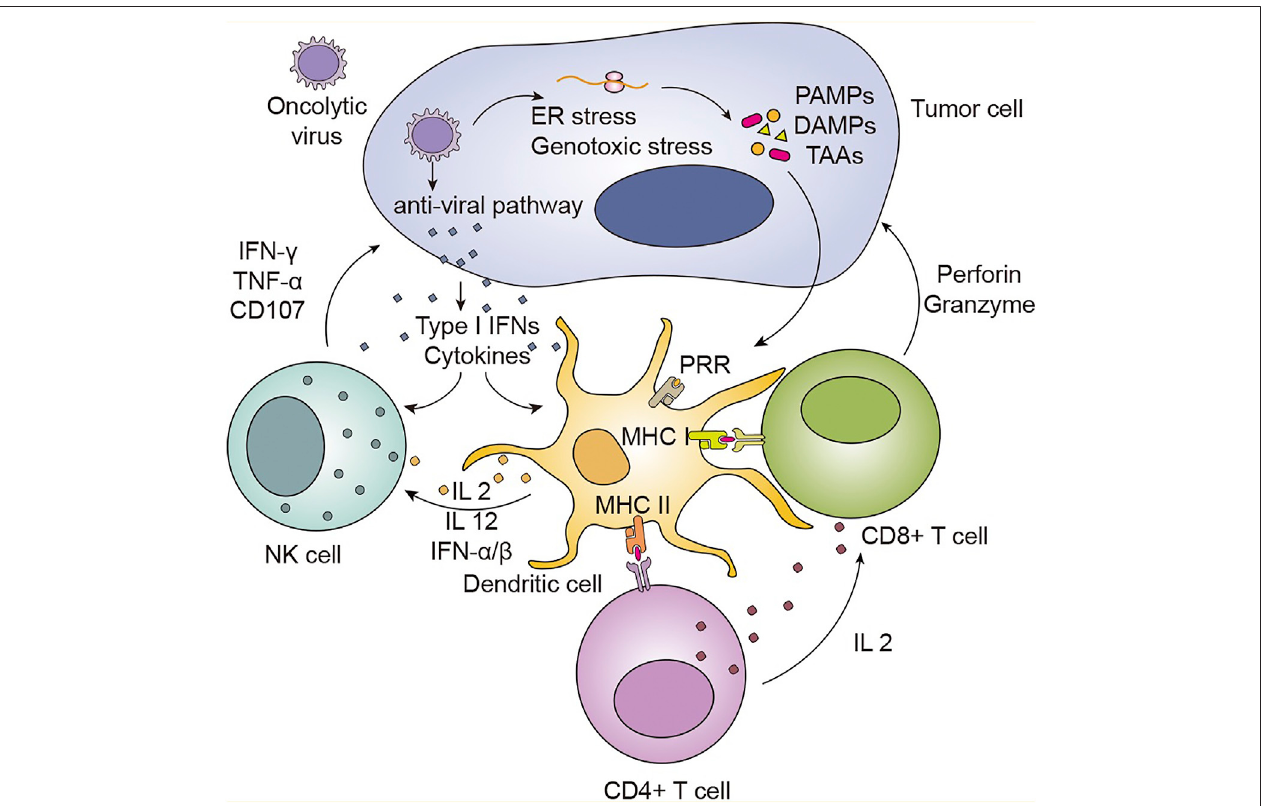
FIGURE 2 | Oncolytic viruses can induce host systemic anti-tumor immunity to kill tumor cells. Following viral infection, viral replication leads to ER stress and genotoxic stress in tumor cells, which results in the release of the viral elements TAAs, PAMPs, and DAMPs. Sensing elements, such as PRRs, can recognize these molecules,whichleadstoimmunecellactivationandin fl ammatorysignaltransduction.Withvirusreplication,antiviralpathwayscanbeactivated.Thisactivationinduces the production ofcytokines and type I IFNs, which mediatethe activation and maturation ofimmunecells, such asDCs and NK cells. NK cells migrateto the tumor area under the action of chemokines, such as IL-12, IL-2, and IFN- α / β , and exert antitumoral properties by releasing IFN- γ , TNF- α and CD107. Mature DCs can present antigenic peptides within the context of MHC I molecules to CD4 + T cells and within the context of MHC II molecules to CD8 + T cells. CD8 + T cells are also activated through the stimulation of CD4 + T cells. The activation of CD4 + T cells by DCs helps to activate CD8 + T cells by inducing the production of cytokines such as IL-2. The recognition oftumor surface antigens byantibodies can trigger CTL killingof tumor cells through Fas-FasL interactions, TNF-TNFR signaling, and the perforin/granzyme